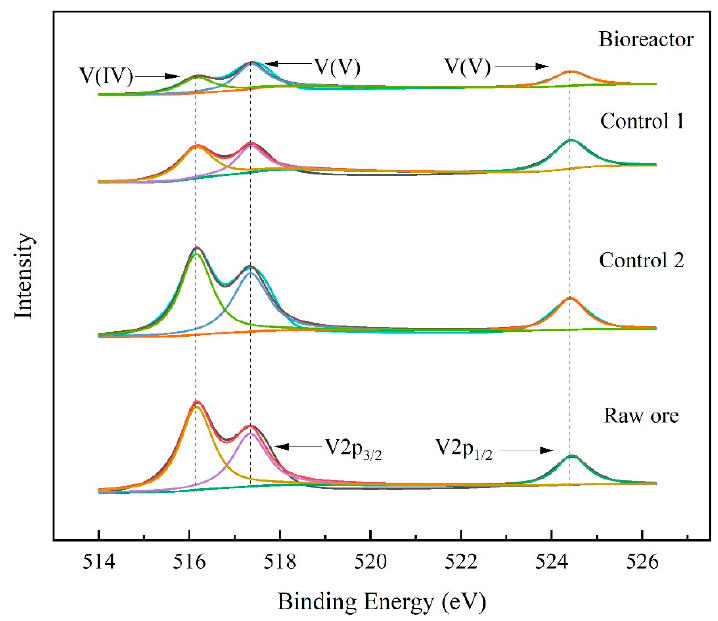
Figure 5. XPS spectra of the V 2P regions in the stone coal before and after